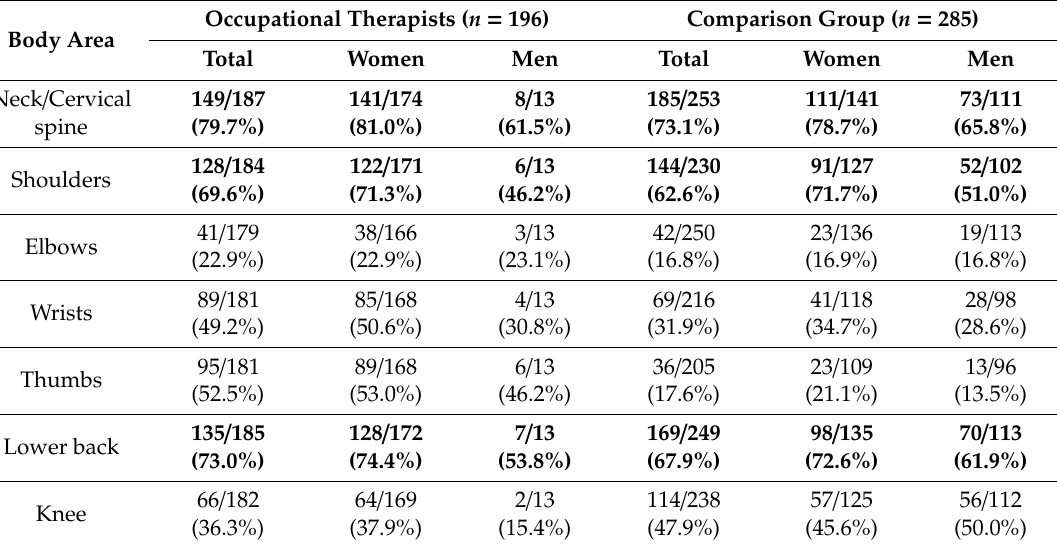
Table 2. 12-month prevalence of musculoskeletal complaints (prevalence / total (%)).